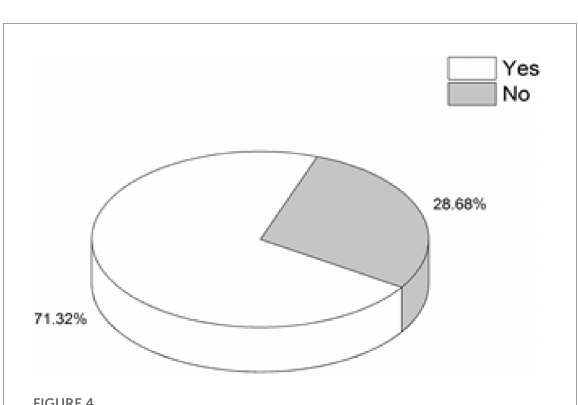
FIGURE4 Percentage of online classes conducted during school closures. FIGURE5